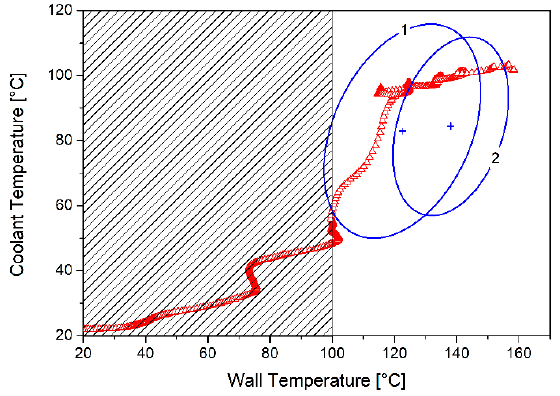
. m f = 18 kg / h). Figure 25. Coolant and wall temperatures for prolonged high load operation ( m(cid:4662) (cid:2916) = 18 kg/h).